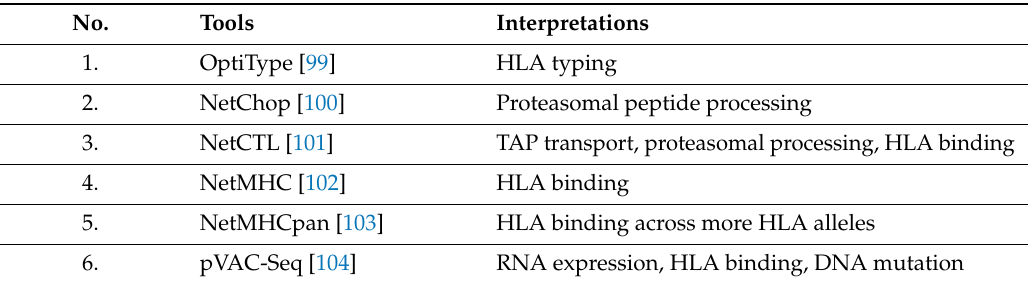
Table 4. Common tools used in neoantigen